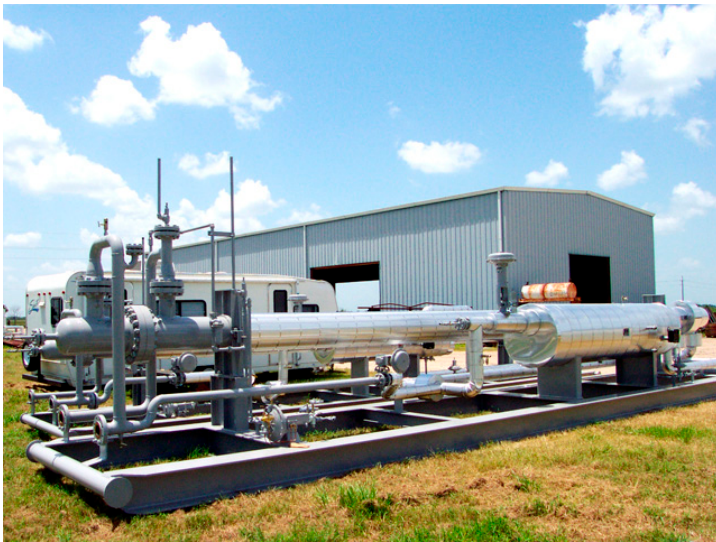
Figure 3. Typical Joule-Thompson low temperature separation (JT-LTS) facility installed in the Yokiri Forcados Integrated Power (FYIP) North Bank Flow Station, Ogulagha Island, Niger Delta. Source: [52].